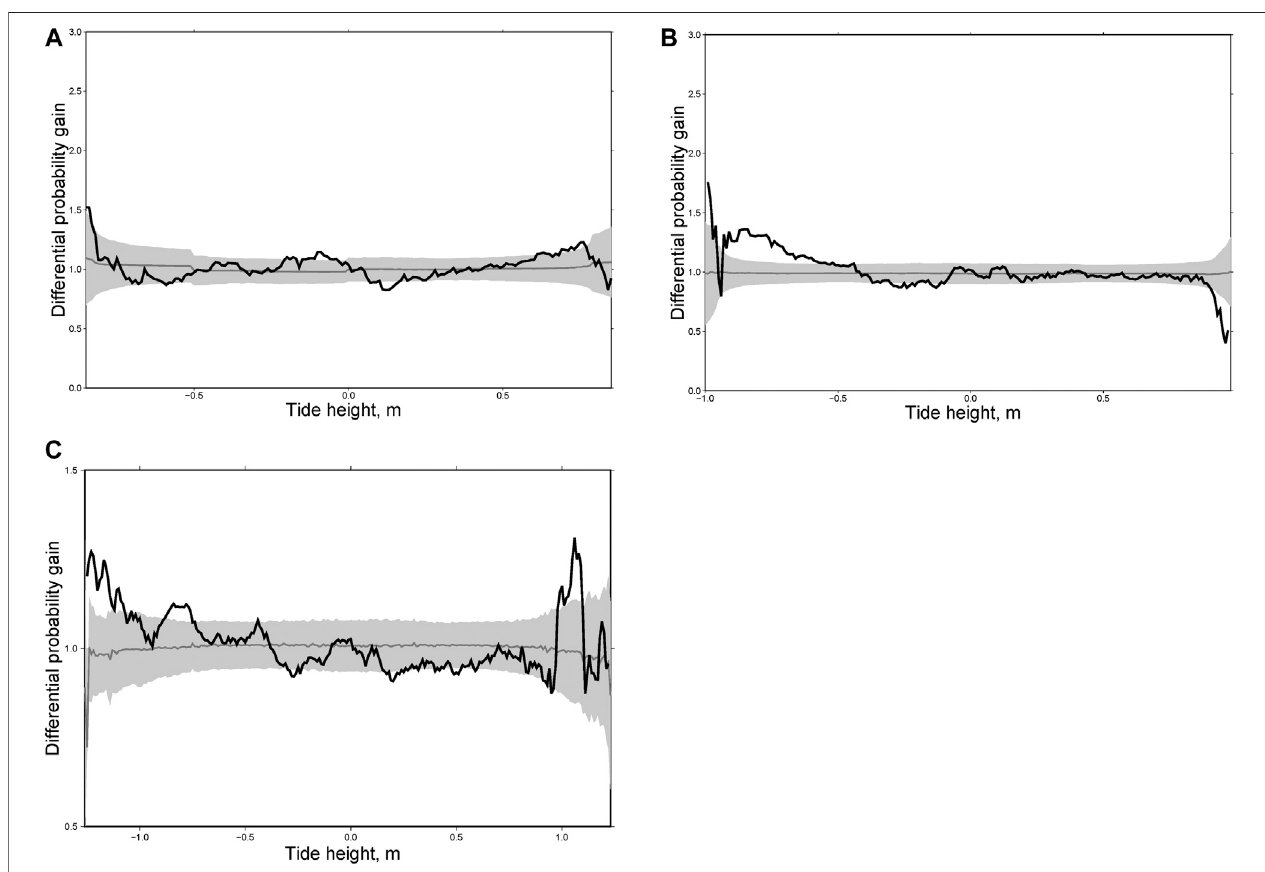
FIGURE11| Differential probability gainfunctionsfor twoaftershocksequences inNew Zealand following theearthquakes ofM (cid:1) 6.3, June 21,1992 (A) ; M (cid:1) 7.8, November 13, 2016 (B) ; and the integral differential probability gain function for six sequences with normal slip of main shocks (C) .